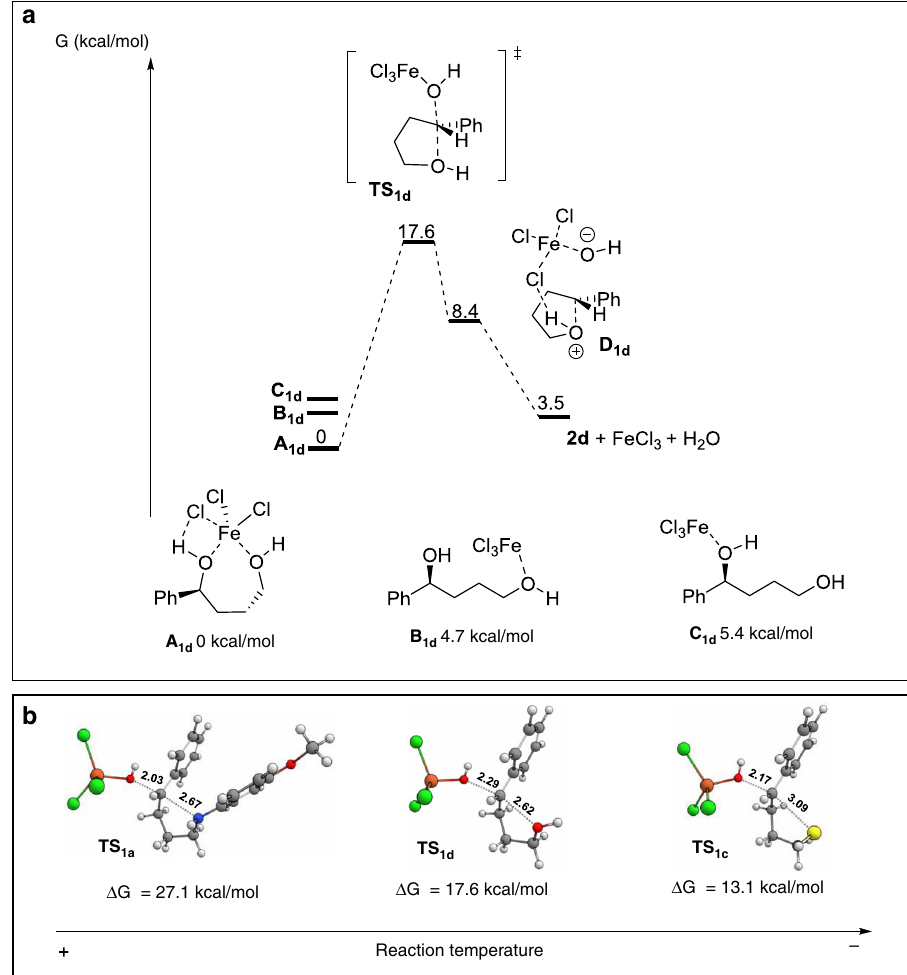
Fig. 5 DFT studies. a Structures for intermediate iron complexes A, B and C generated from interactions between FeCl 3 and 1d and their corresponding energy pro fi les for the intramolecular S N 2-type nucleophilic substitution reaction. b Structures and energies for substrates 1a , c , and d in the transition states